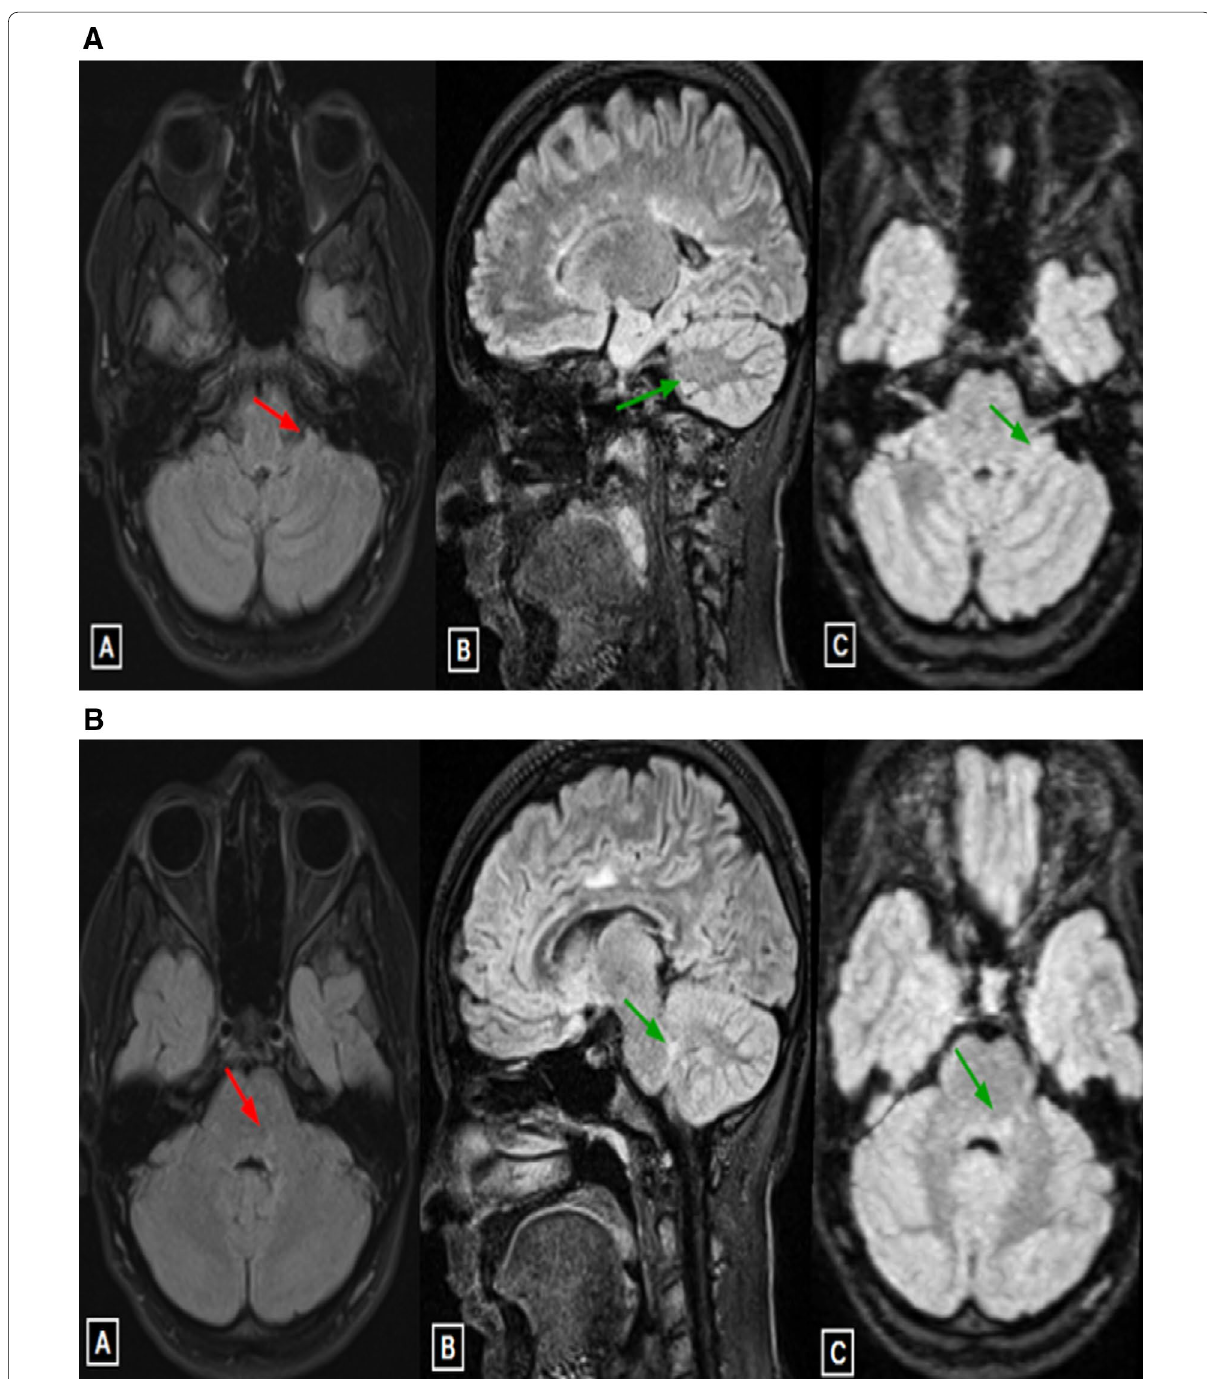
Fig. 6 Infra-tentorial lesions: A shows no detectable MS lesion, that are only seen at B , C in 3D FLAIR and MIP